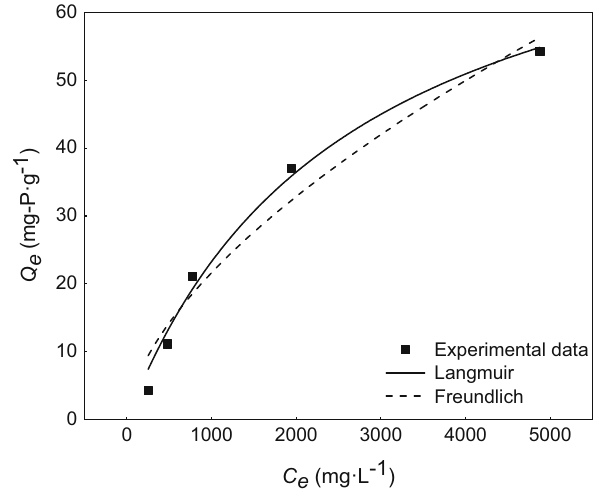
Figure 8: The isothermal adsorption fi tting curves of phosphorus on synthetic zeolite.